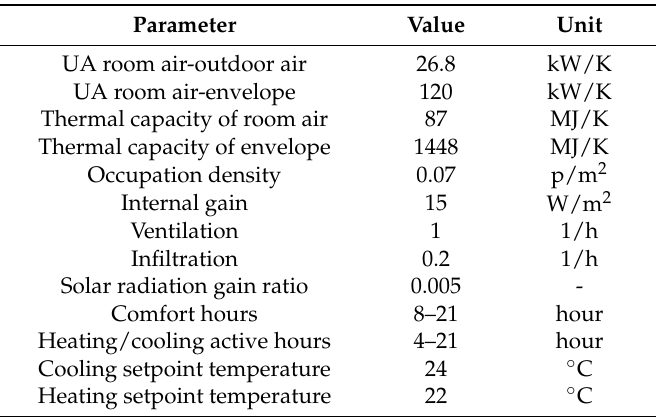
Table A3. Building model input figures.